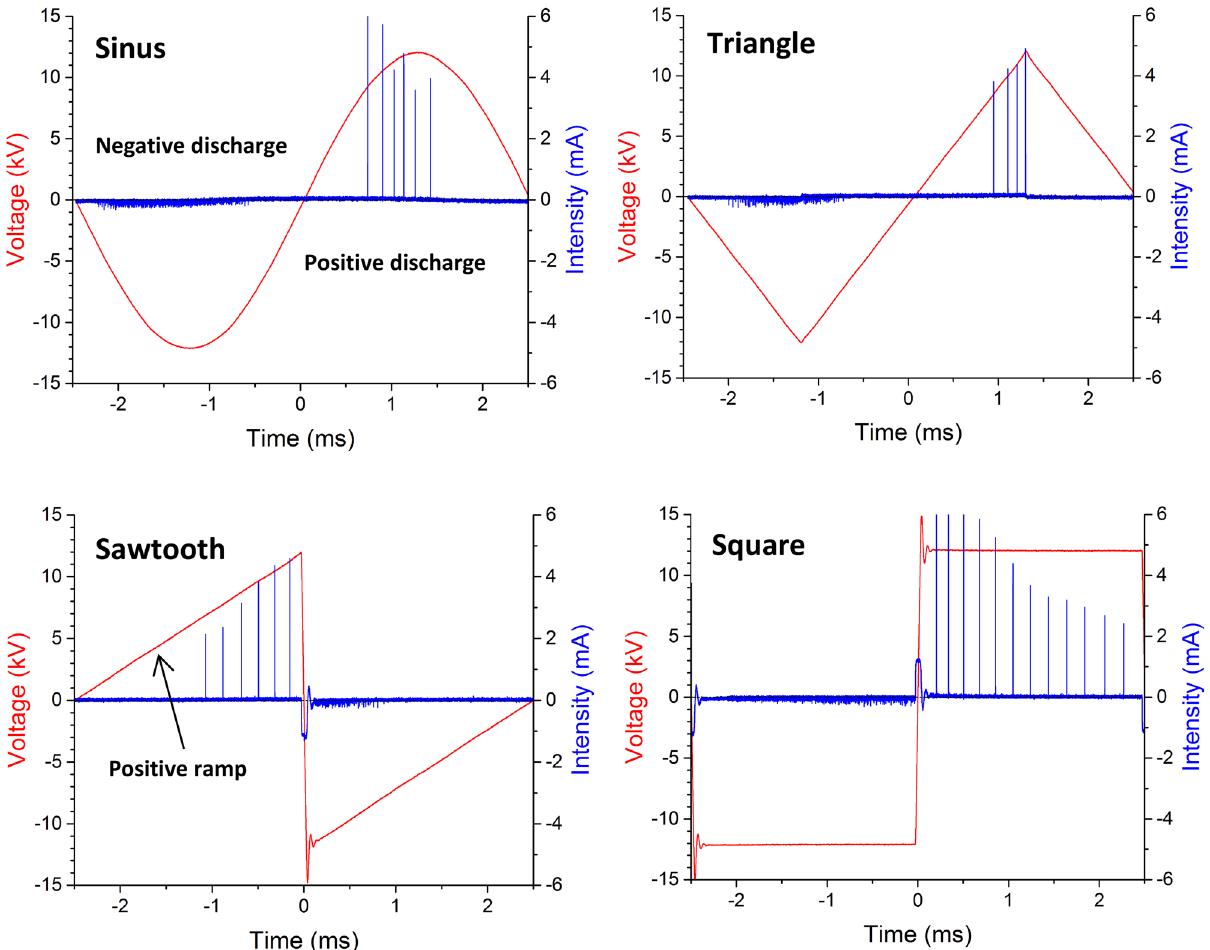
Figure 1. Voltage and discharge current versus time for a voltage amplitude V AC = 12 kV and a voltage frequency f AC = 200 Hz for different voltage